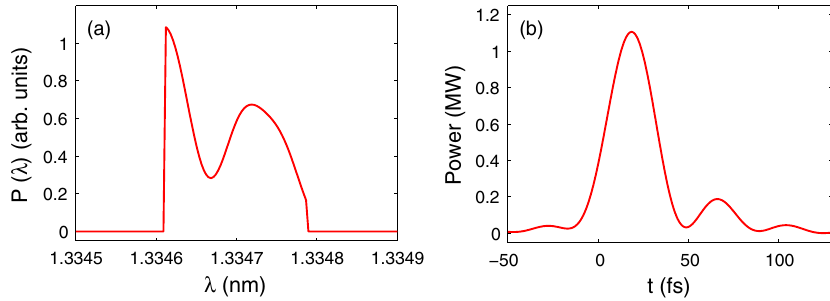
FIG. 11. FEL spectrum (a) and power (b) after the